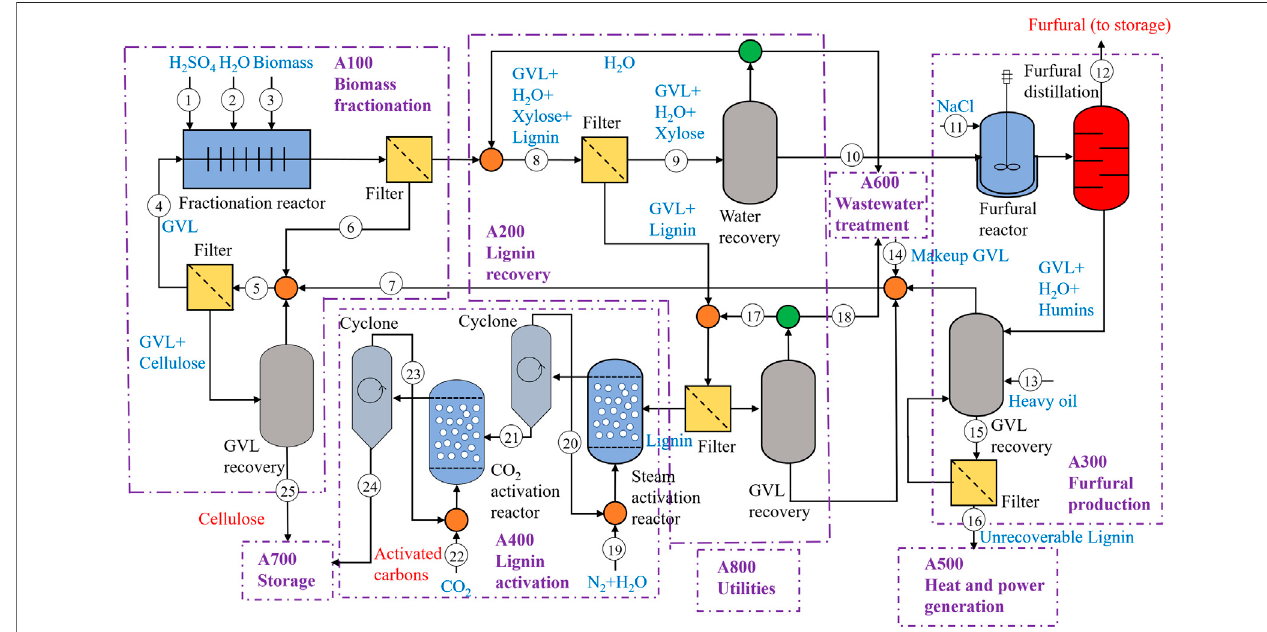
FIGURE 10 | Simpli fi ed process fl ow diagram to produce activated carbons, furfural, and cellulose from biomass.